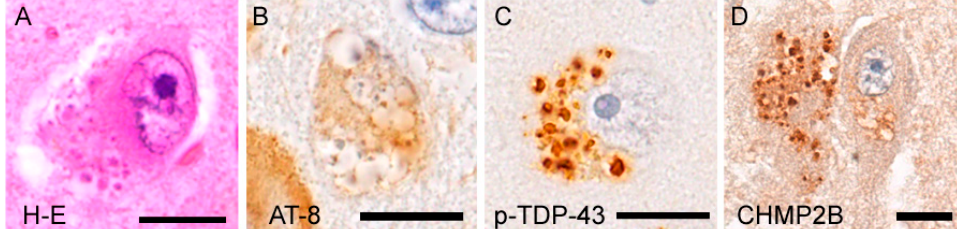
Figure 4. Granurovacuolar degeneration. Granurovacuolar degeneration (GVD) is characterized by a cluster of slightly basophilic granules within fused vacuoles ( A ). The granules are immunopositive for hyperphosphorylated tau ( B ), phosphorylated TDP-43 ( C ), and CHMP2B ( D ) [87,91]. Note that cy- toplasm of the GVD-containing neuron also shows diffuse immunoreactivity to hyperphosphorylated tau ( B ). Bars = 10 µ m. ( A – D )